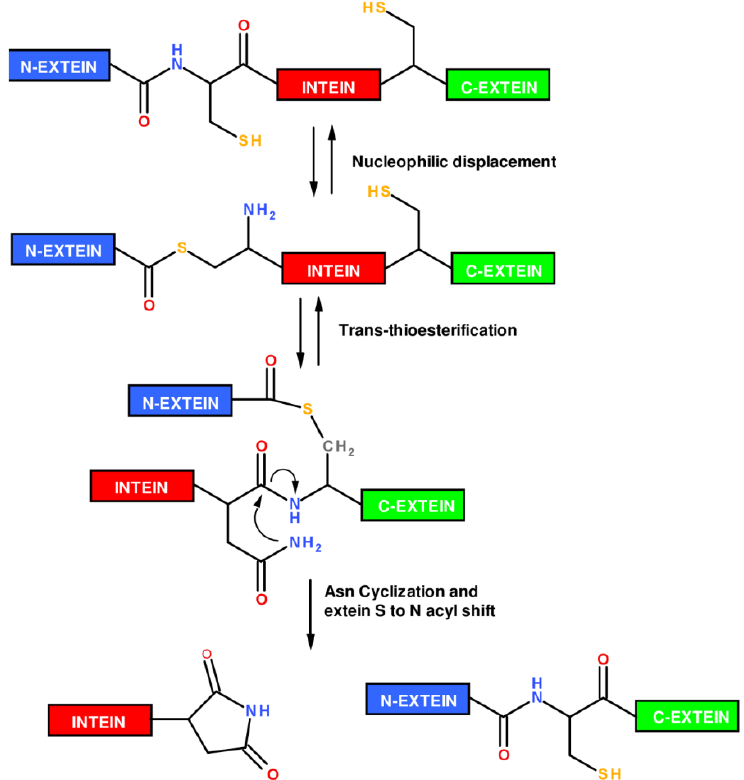
Figure 4. Mechanism of the intein protein splicing